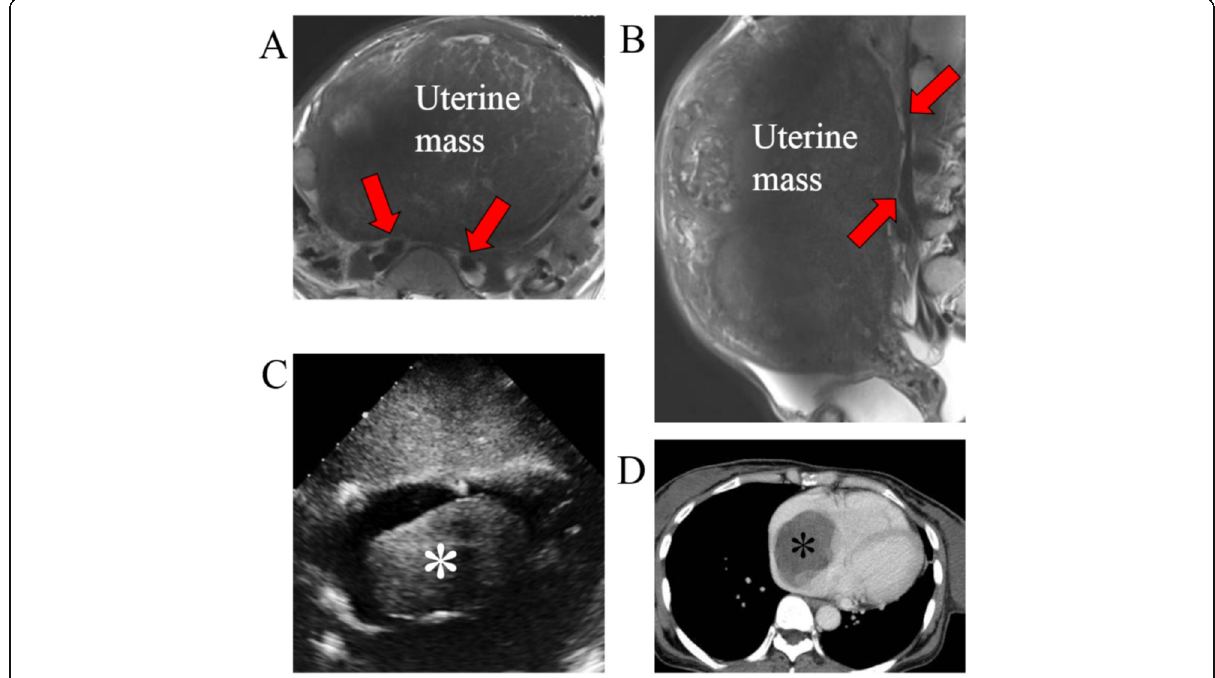
Fig. 1 Clinical imaging findings: a and b T2-weighted MRI revealed a 27-cm mass in the uterus. No tumor was detected in the iliac vein (A, red arrows) or in the inferior vena cava (B, red arrows). c Echocardiography imaging revealed a 78 × 47-mm mass (asterisk) in the right atrium. d Enhanced computed tomography imaging confirmed a 75-mm mass (asterisk) in the right